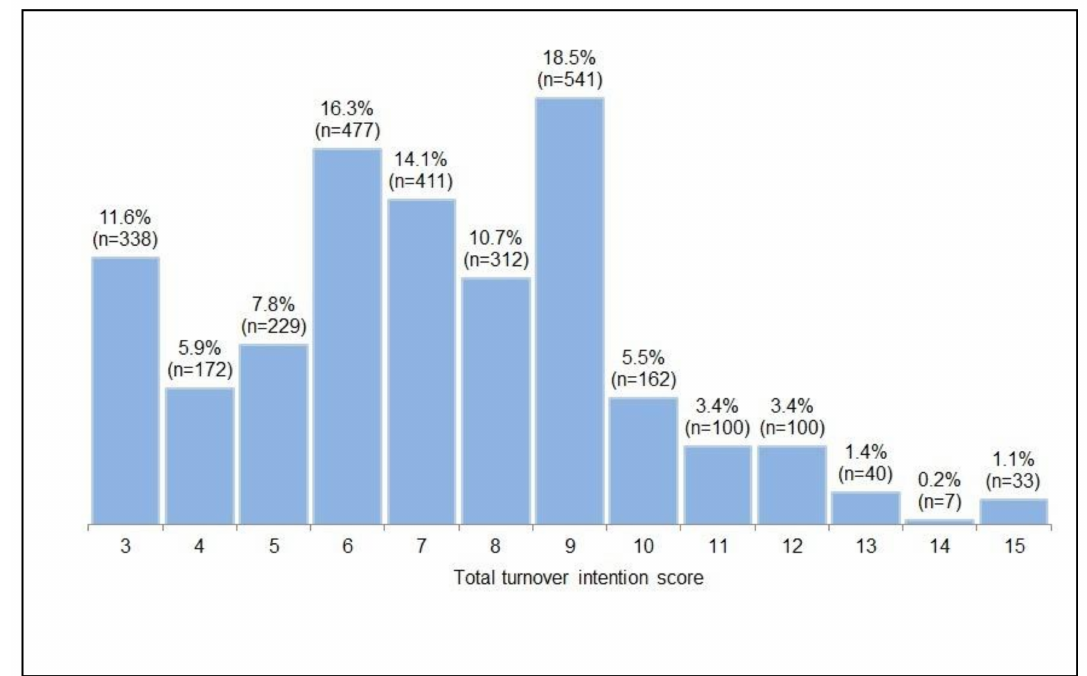
Figure 5. Distribution of turnover intention score (N =